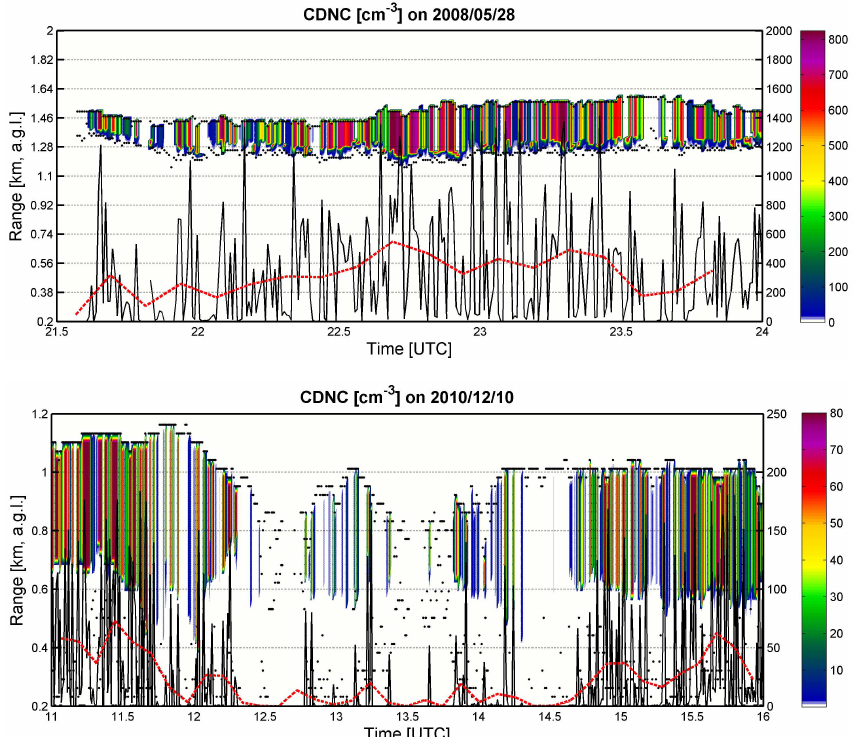
Fig. 5. Continental (top) and marine (bottom) case: time-height cross section of the CDNC [cm − 3 ]. Layer-averaged black and red curves at each panel’s bottom (right y-scale in [cm − 3 ]) have 0.5-min and 7.5-min temporal resolution,